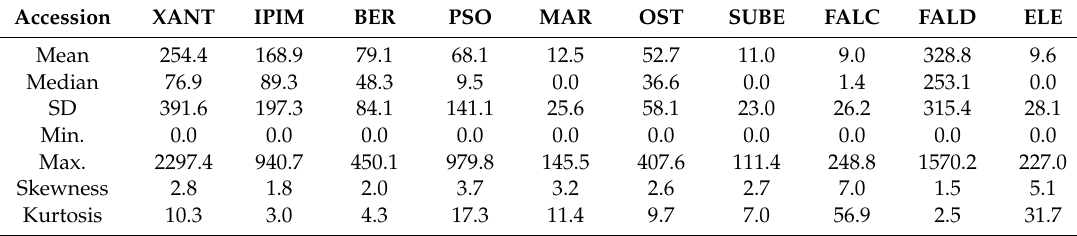
Table 1. Selected statistical characteristics for 152 samples from 16